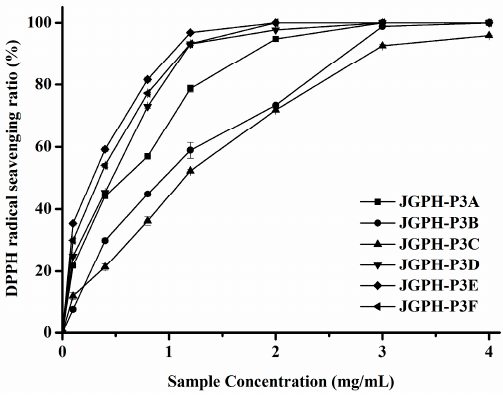
Figure 3. DPPH radical scavenging activity of JGPH-P3 A–F.